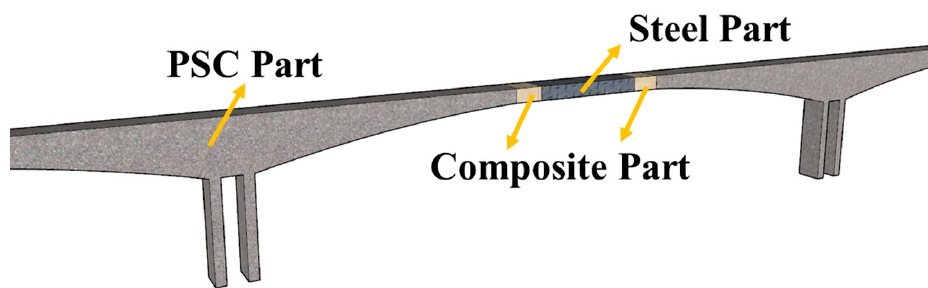
Figure 1. Illustration of a hybrid continuous bridge.